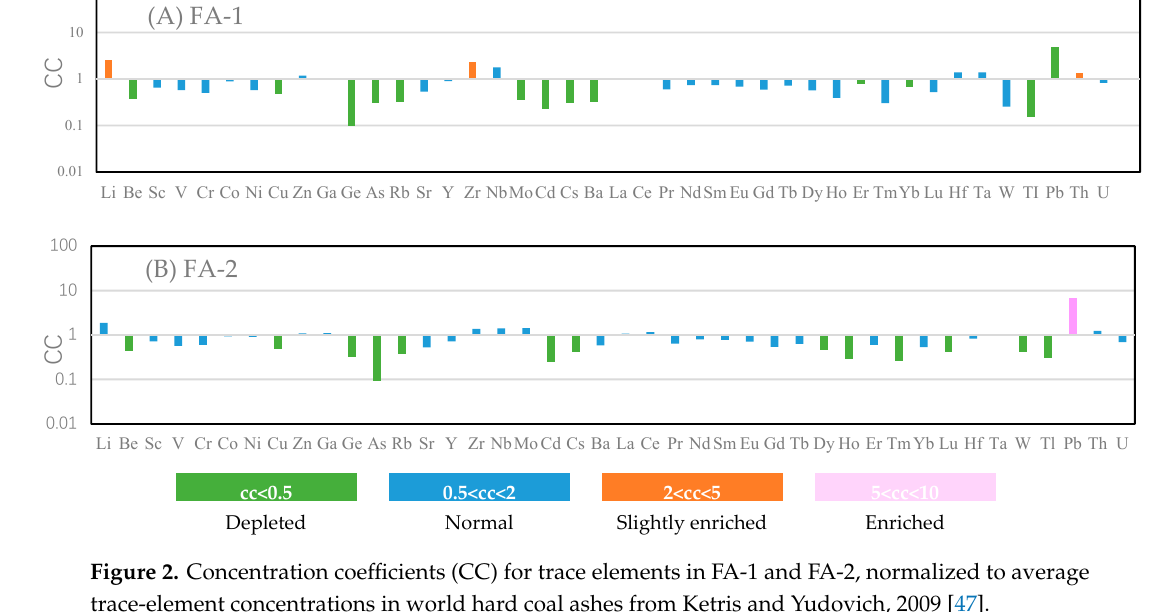
Figure 3. X-ray diffraction (XRD) patterns for FA-1( a ) and the feed coal for FA-1( b ).